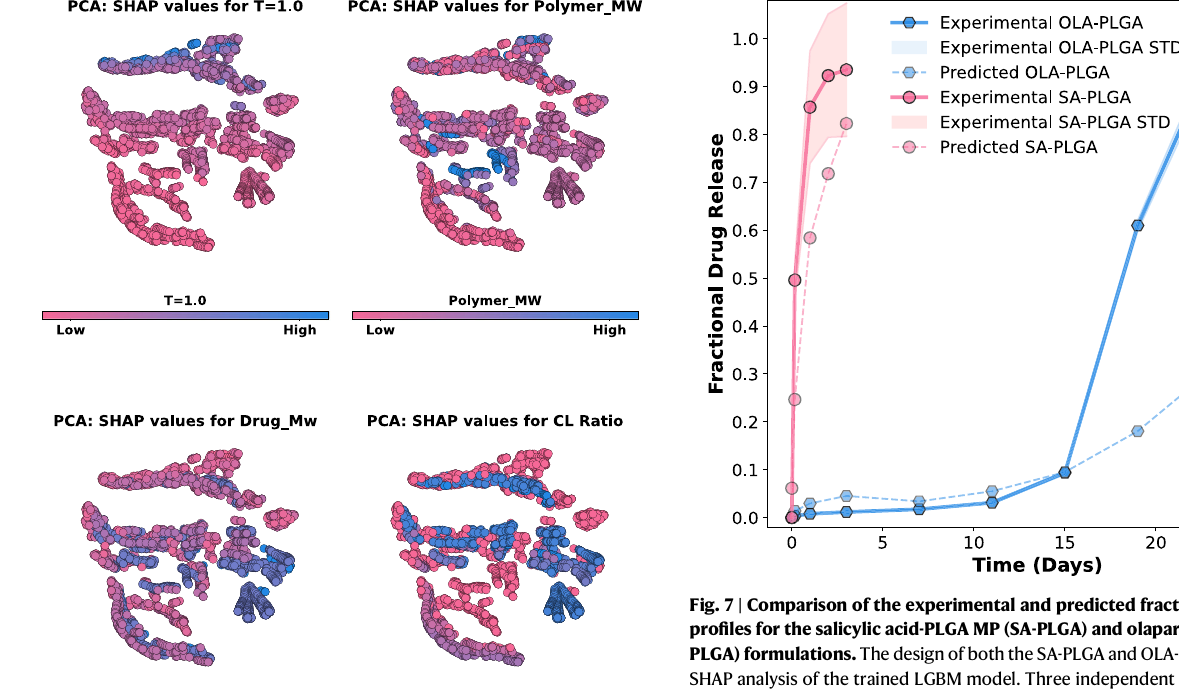
Table 3 | Table highlighting key design criteria for “ fast ” and “ slow ” release PLGA MPs based on SHAP analysis of the 15- featureLGBM modelandthe observed trendsin thePCAplots Feature/property